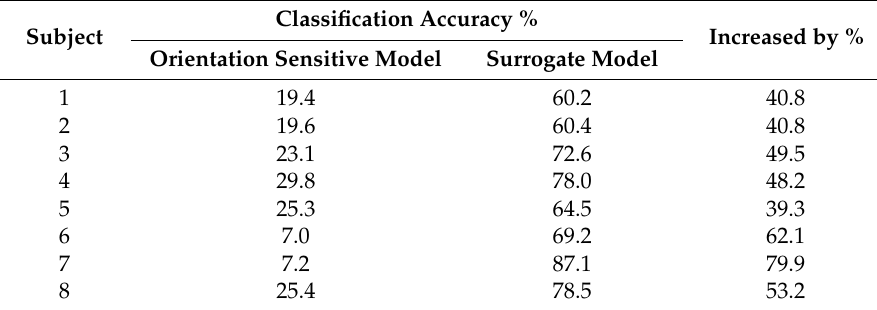
Table 3. Performance of the orientation-sensitive model and rotation-invariant (surrogate) model in case of recordings with axes’ rotation.